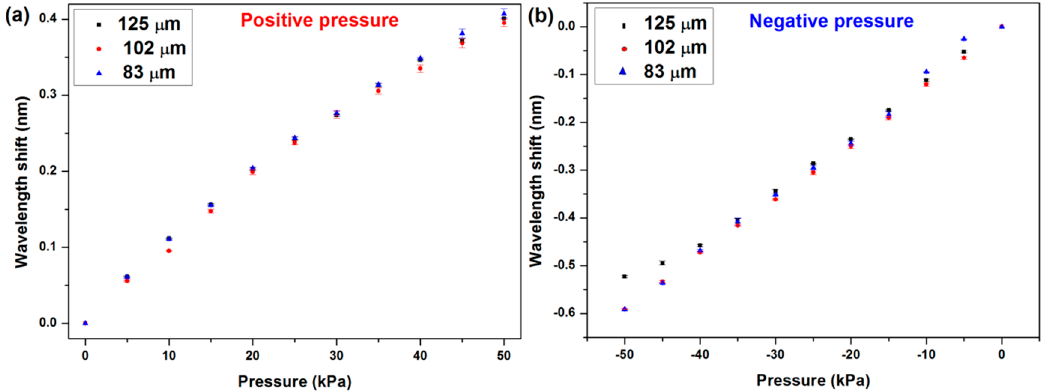
Figure 5. ( a ) Positive pressure sensitivities and ( b ) negative pressure sensitivities of the sensors with different diameters.